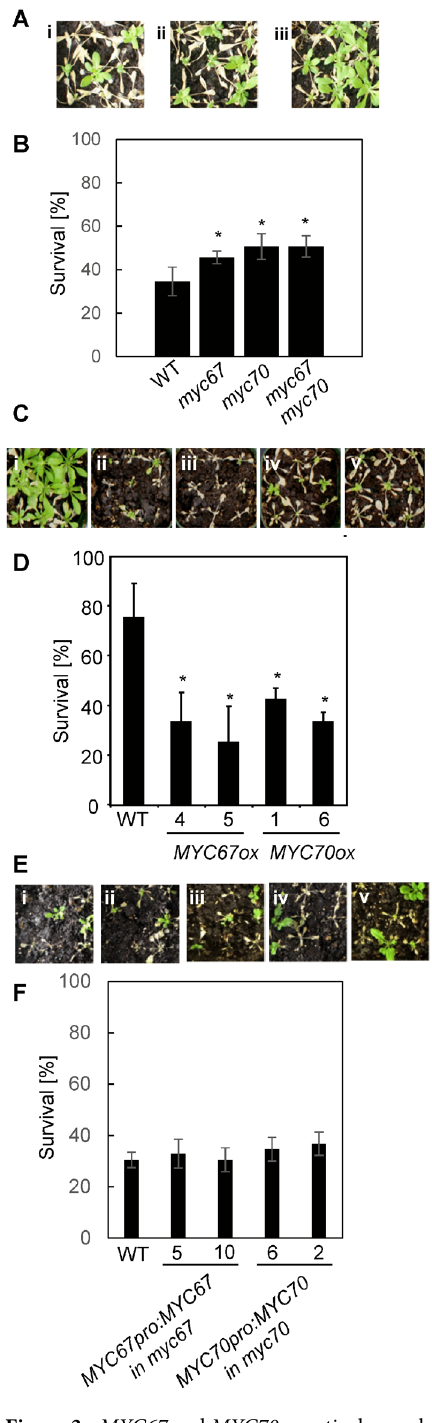
Figure 3. MYC67 and MYC70 negatively regulate freezing tolerance. ( A ) The freezing tolerance of myc67 and myc70 after cold acclimation. Representative wild-type (i), myc67 (ii) and myc70 (iii) plants that were treated with − 7 °C are shown. ( B ) Quantification of the survival rates for the cold-acclimated wild-type, myc67 , and myc70 plants after a − 7 °C freezing treatment. The data indicate the means and standard errors (n = 6). The tolerance of myc67 , myc70 , and myc67 myc70 mutants was significantly different from that of wild- type plants (t-test, P < 0.05). ( C ) MYC67 -, and MYC70 -overexpressing plants exhibited freezing sensitivity. The plants shown are representative wild-type plants (i), MYC67- overexpressing plants #4 (ii) and #5 (iii), and MYC70- overexpressing plants #1 (iv) and #6 (v). ( D ) Quantification of the survival rates for the cold- acclimated MYC67 -, and MYC70 -overexpressing plants after a − 6 °C freezing treatment. The data indicate the means and standard errors (n = 6). The survival ratios of MYC67 -, and MYC70 -overexpressing plants were significantly different than that of wild-type plants (t-test, P < 0.05). ( E ) MYC67pro:: FLAG:MYC67 or MYC70pro:: FLAG:MYC70 was expressed in myc67 or myc70 mutant, respectively. The mutant phenotype